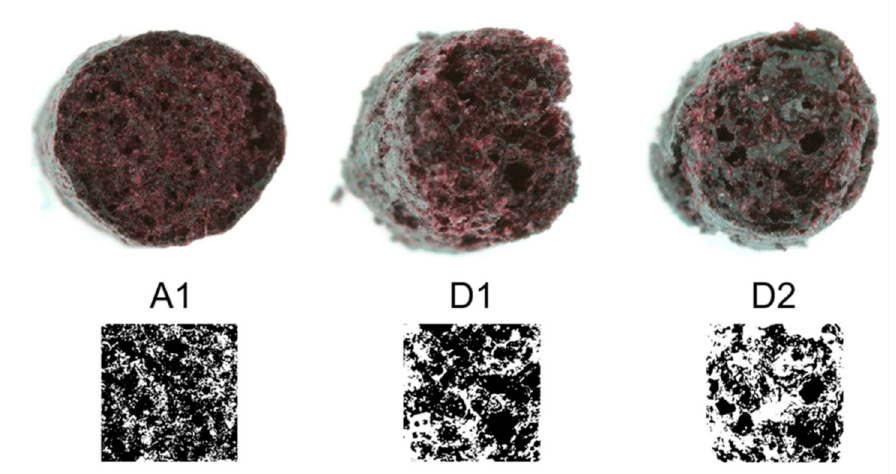
Figure 5. Cross section and porosity of chokeberry pomace powder (CPP) extrudates after extrusion processing at different specific mechanical energies (SME) applied at different water contents (c w ). (A1) SME 145 ± 6 Whkg − 1 , c w 13%; (D1) SME 222 ± 10 Whkg − 1 , c w 13%; (D2) SME 190 ± 9 Whkg − 1